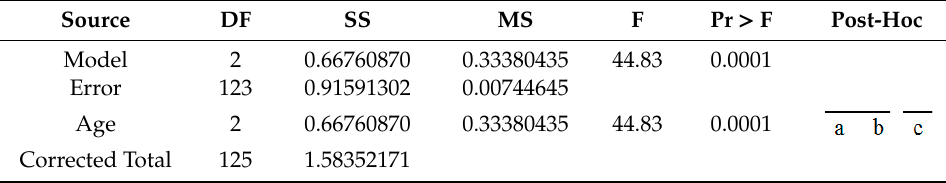
Table 6. Tukey post-hoc analysis in female participants according to age.